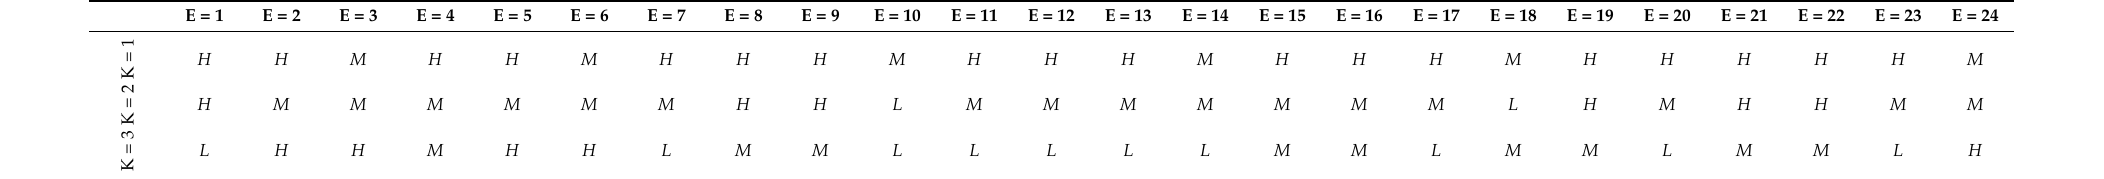
Table 4. Fuzzy rating of the relative importance of